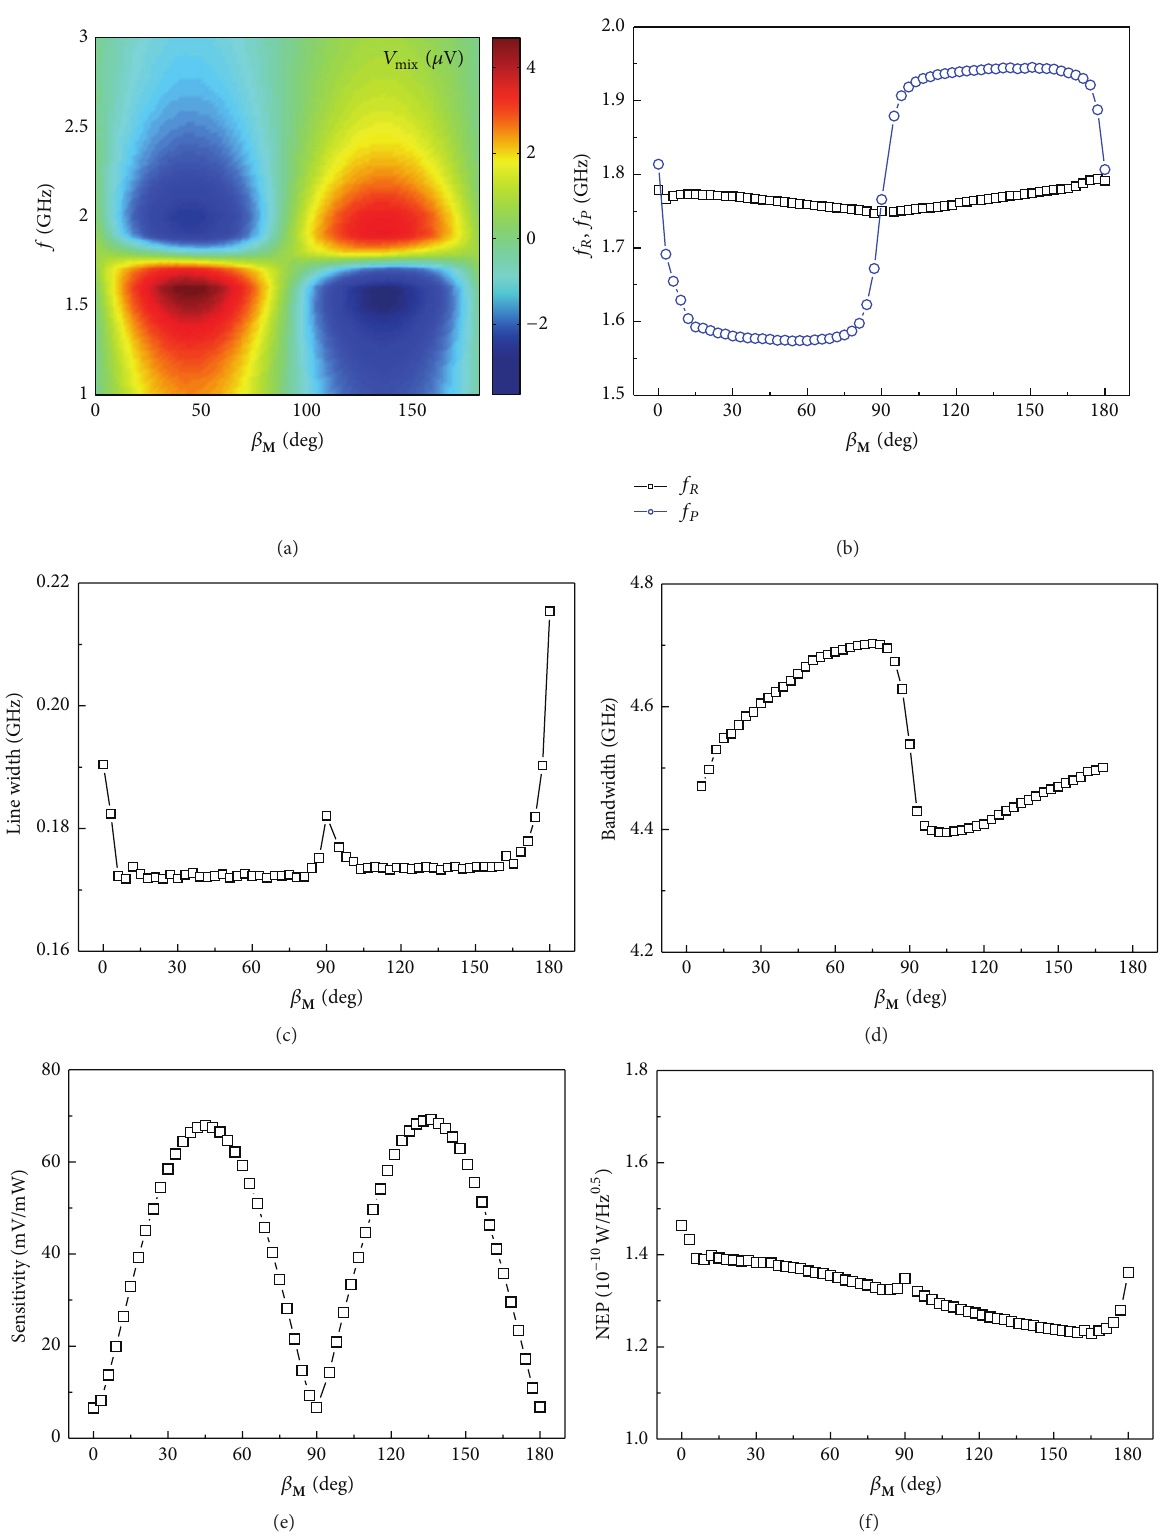
Figure 3: (a) The contour plots of 𝑉 mix - 𝑓 spectra, (b) 𝑓 𝑅 and 𝑓 𝑃 , (c) line-width, (d) bandwidth, (e) sensitivity, and (f) NEP as a function of 𝜇 𝐻 = − 60 mT is applied at 𝜃 𝛽 M when 0